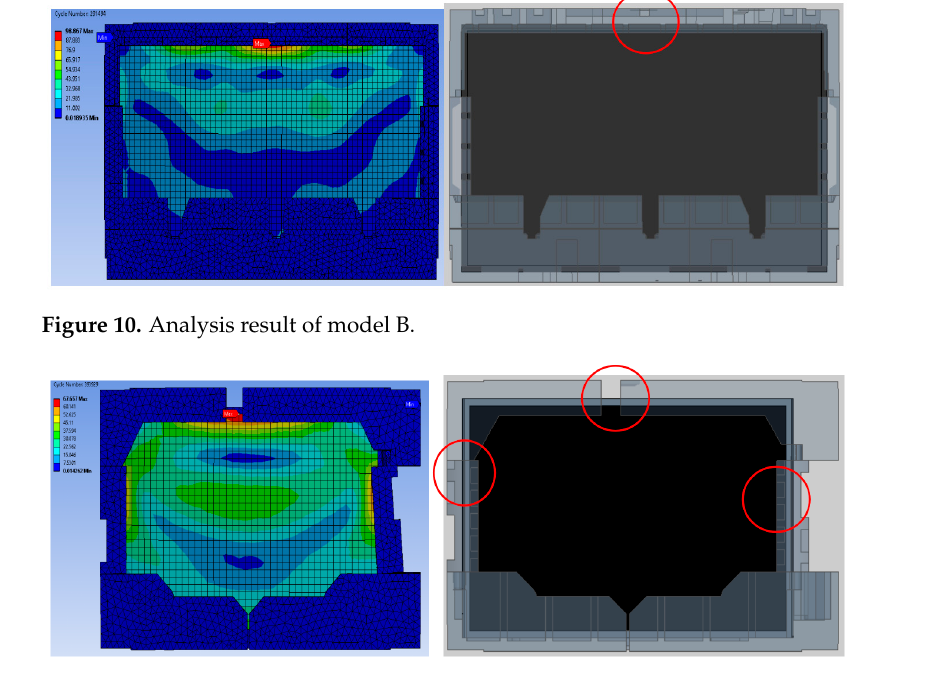
Figure 11. Analysis result of model C.